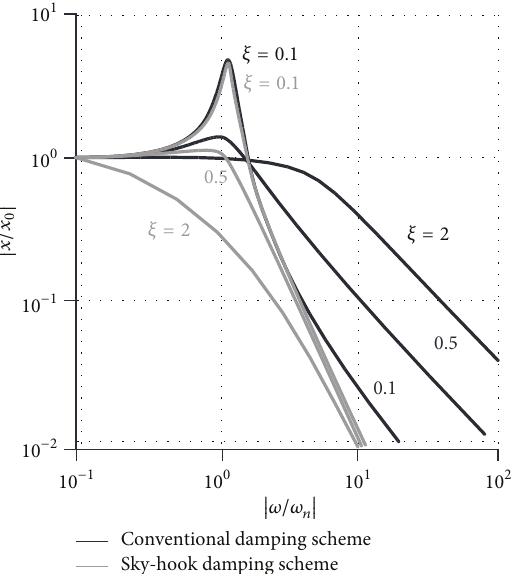
Figure 8: Conventional (black) and ideal sky-hook (grey) damping schemes: comparison of vibration transmissibility at three levels of damping ratio (rearranged from [14]).